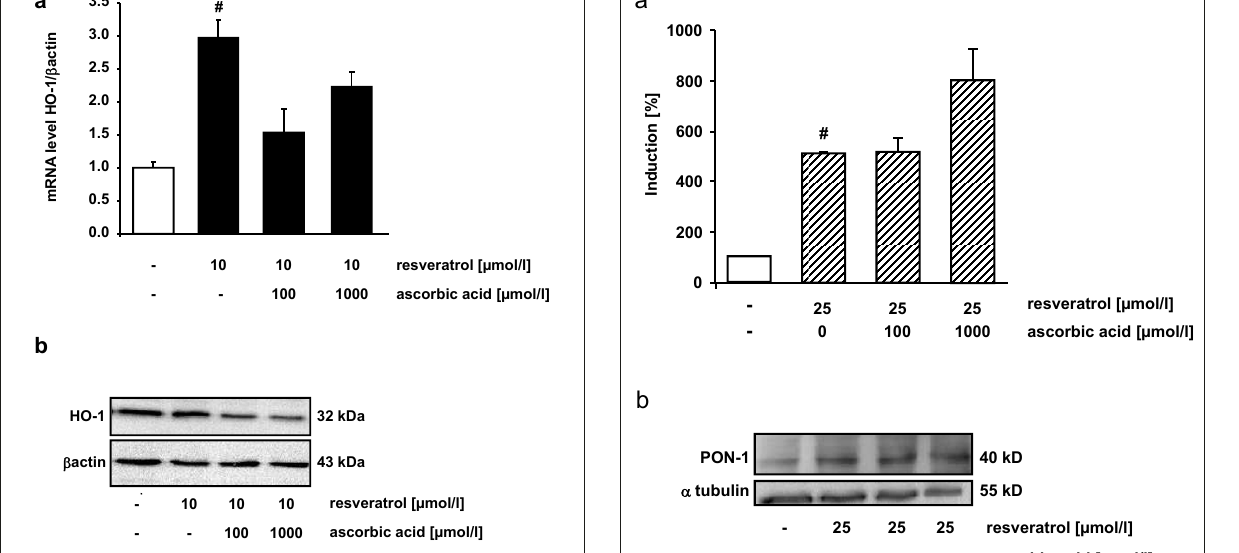
Figure 3 Effects of resveratrol and ascorbic acid on HO-1 mRNA and protein levels . mRNA (a) and protein levels (b) of HO-1 in HUH7 cells in response to resveratrol supplementation in the absence and presence of 100 and 1000 μ mol/l ascorbic acid. Data are mean ± SEM of at least 3 experiments performed in triplicate. # indicates significant difference between control and 10 μ mol/l resveratrol p < 0.05, Mann-Whitney-U-Test. peroxide were generated.